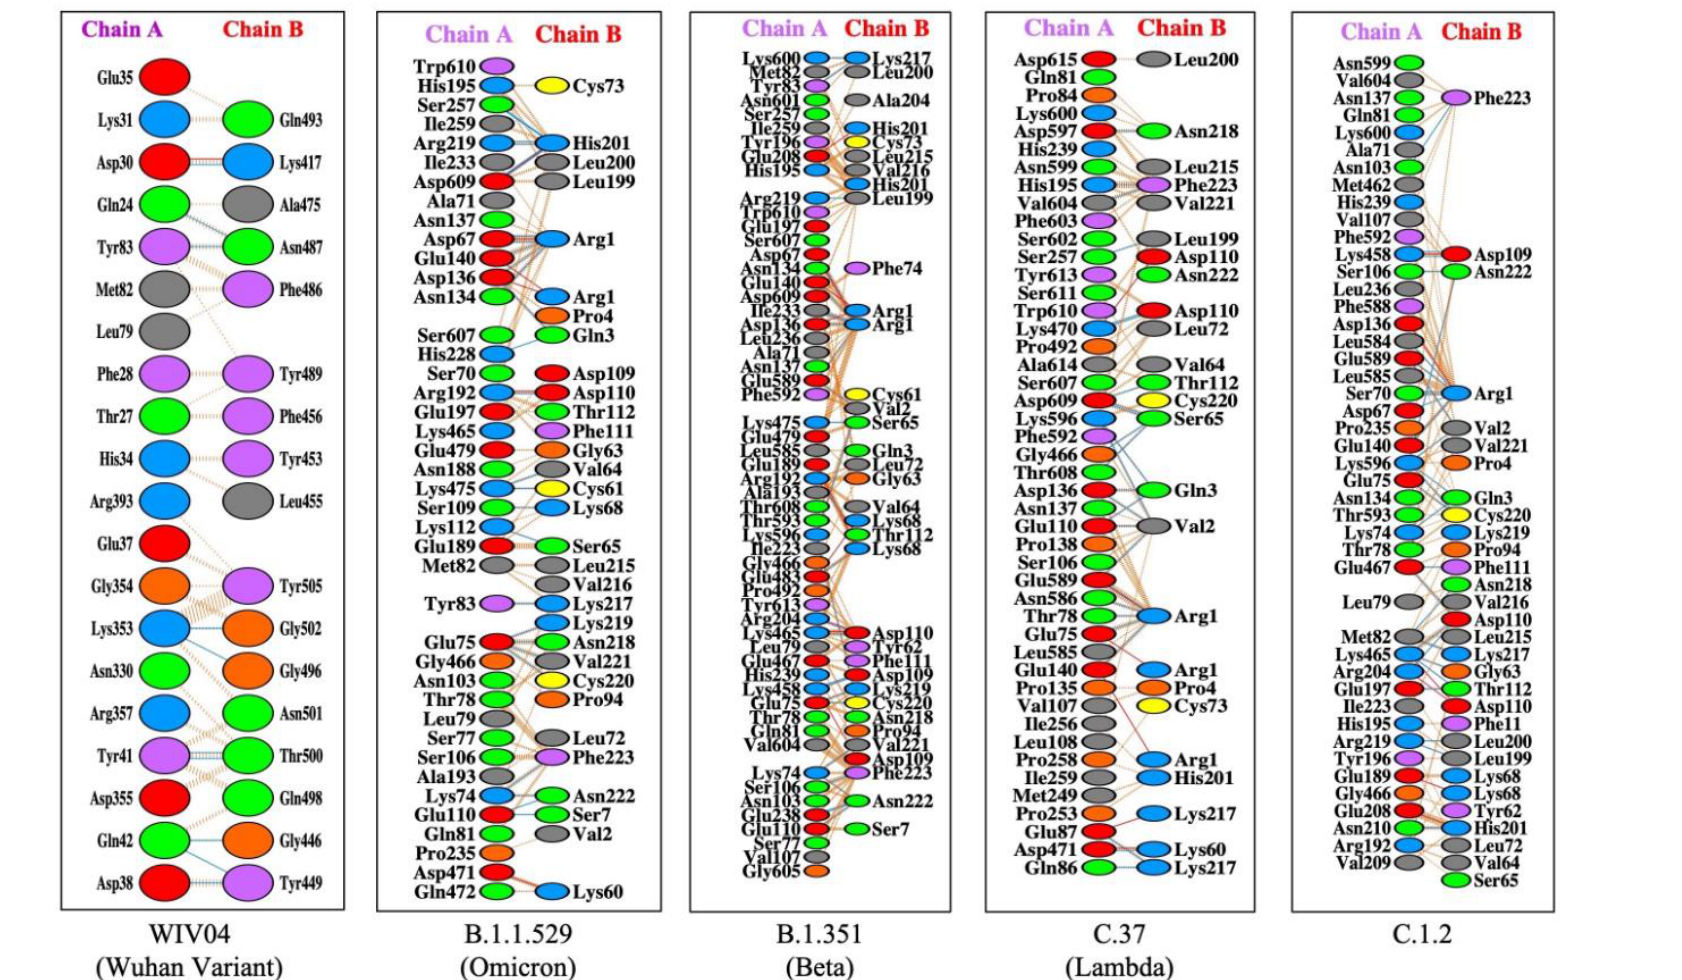
Figure 2: Protein–protein docking representation of hACE2 and RBD of SARS CoV-2. The interaction representation, which includes hydrogen (blue line), salt bridges (red line), and non-bonded (orange dash) interactions. Chain A represents hACE2 and chain B represents RBD. Residue colors: positive (blue): His, Lys, Arg; Negative (red): Asp, Glu ; Neutral (green): Ser, Thr, Asn, Gln; Aliphatic (grey): Ala, Val, Leu, Ile, Met; Aromatic (purple): Phe, Tyr, Trp; and Pro & Gly